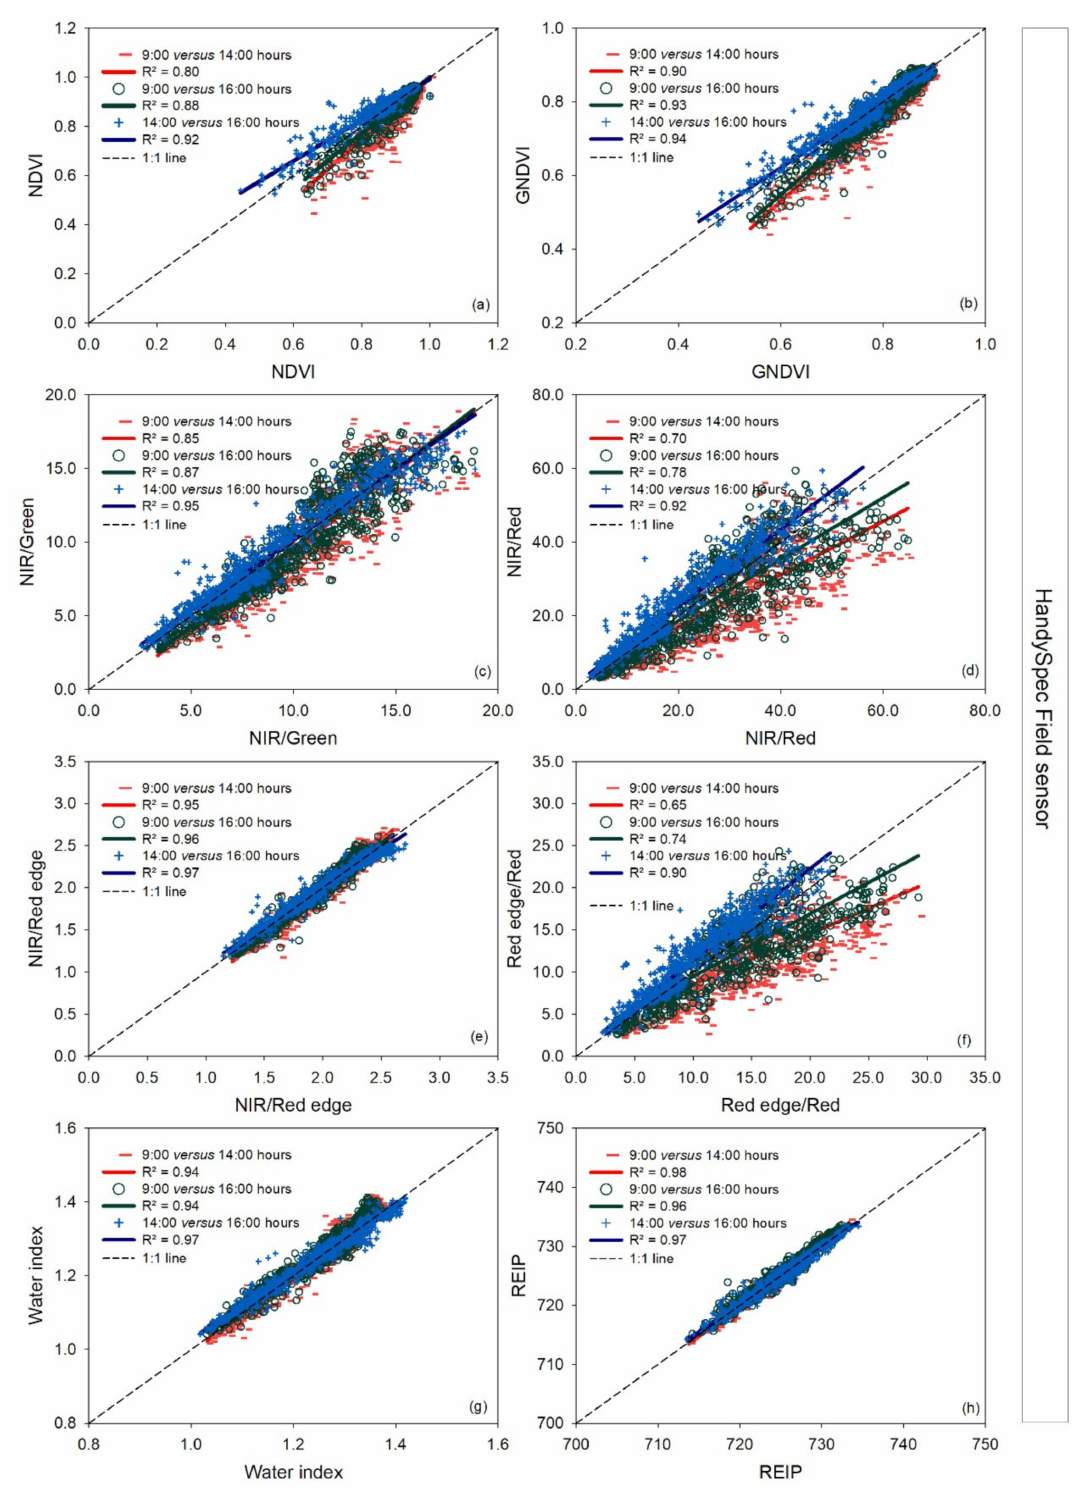
Figure 5. Linear regressions between paired measurement times (9:00 versus 14:00 h, 9:00 versus 16:00 h, and 14:00 versus 16:00 h) for each vegetation index measured with the handheld hyperspectral bidirectional HandySpec Field sensor for the three measurement dates together. R 2 : coefficient of determination. The dashed line represents the 1:1 line. In the pairwise comparison, the earlier time is indicated on the x-axis and the later time on the y-axis ( a – h